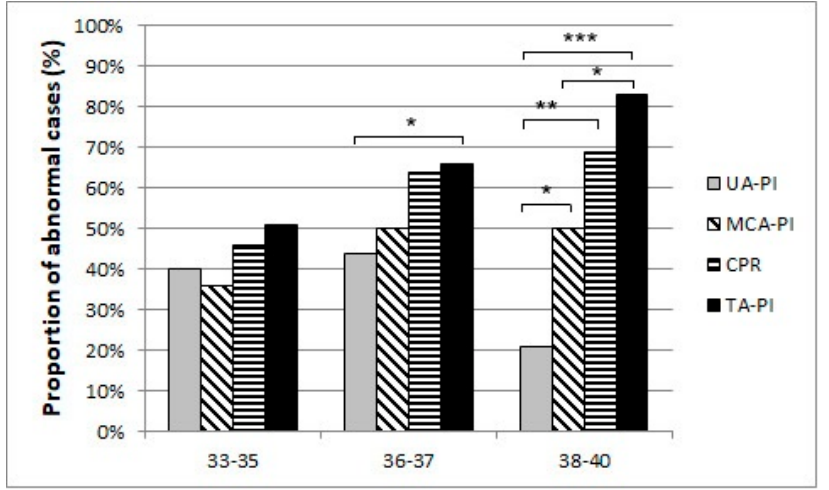
Figure 5. The proportion of abnormal cases in the umbilical artery (UA-PI), the middle cerebral artery (MCA-PI), cerebroplacental ratio (CPR), and the tibial artery (TA-PI) Doppler findings between 33 and 35, 36 and 37, 38 weeks of gestation and last examination before delivery ( p -Values *** p < 0.001, ** p < 0.01, * p < 0.05).